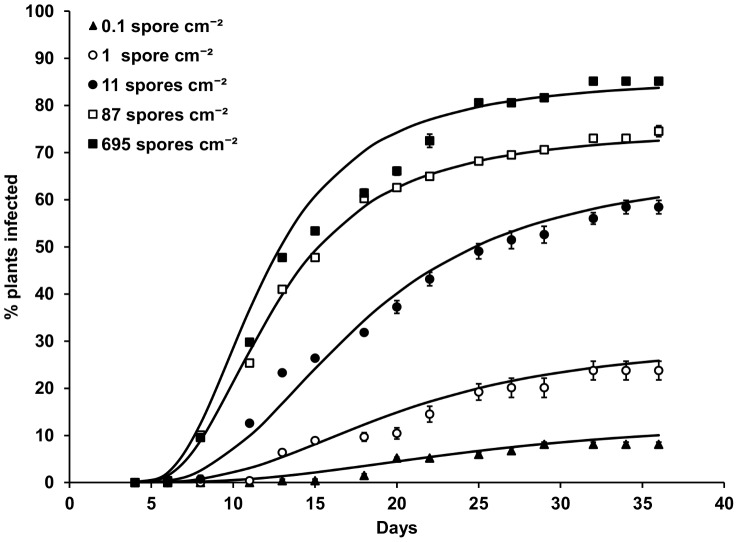
Effect of S. sclerotiorum spore density on disease development in lettuce at 20°C and 85% RH.Points represent observed data, lines represent fitted functions. Error bars are the standard error of the mean (three replicates).